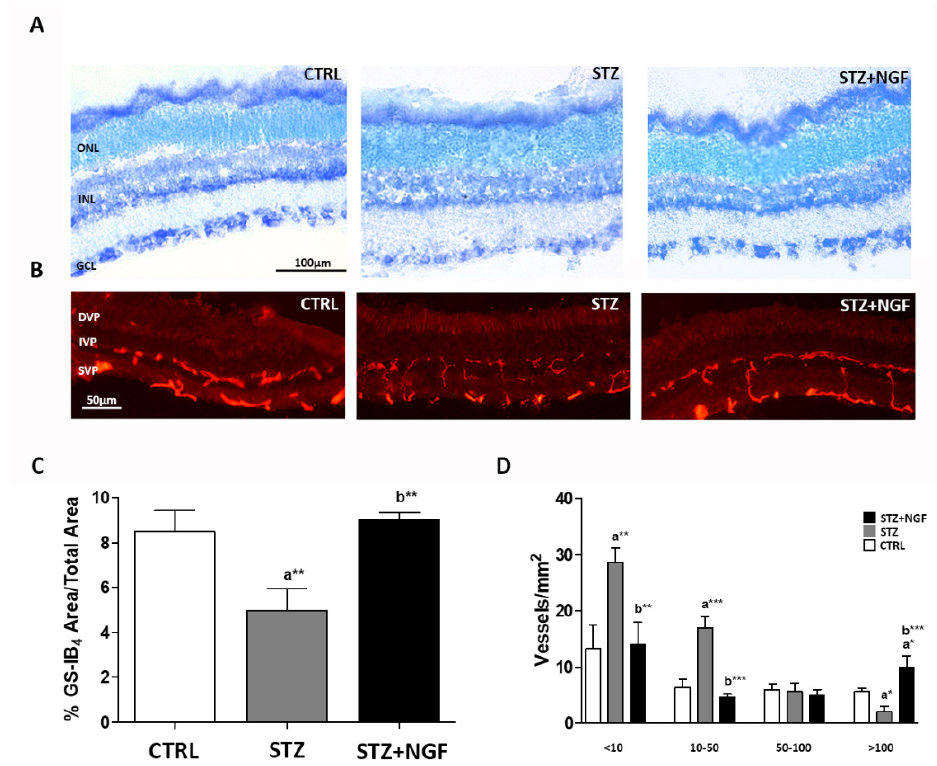
Figure 1. ( A – D ). Retinal histology and vasculature are affected by diabetes (STZ) and NGF eye drops administration (STZ+NGF). ( A ) Toluidine blue stain (black bar = 100 µ m) revealed changes when comparing inner nuclear layer (INL) and ganglion cell layer (GCL) of STZ rat retinas with the healthy (CTRL) and STZ+NGF groups, while minor differences were observed between CTRL and STZ+NGF. ( B ) The distribution of GS-IB 4 -positive vessels in the retina (red stain), white bar = 50 µ m. A fragmentation of retinal vessels in the area between the superficial vascular plexus (SVP) and intermediate vascular plexus (IVP) was observable in the diabetic retina with respect to healthy and STZ+NGF groups, respectively. ( C , D ) The results of computer analysis of vasculature reported the effects of STZ on the area fraction ( C ) and on the size distribution of vessels/mm 2 ( D ) expressed as mean ± SD. Statistical significance is indicated with * p < 0.05, ** p < 0.01, *** p < 0.001. “a” vs. CTRL,